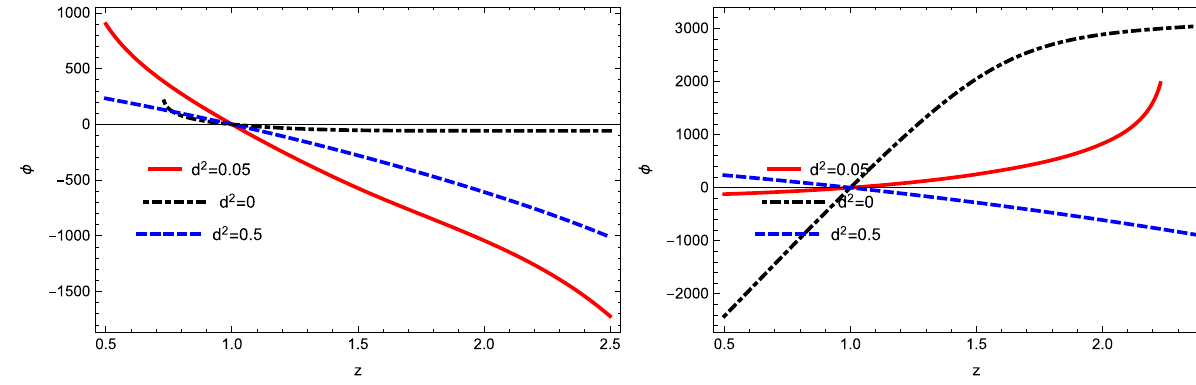
Fig. 40 Plot of φ verses z for u = 1 and u = 2 . 002 for K-essence scalar field model